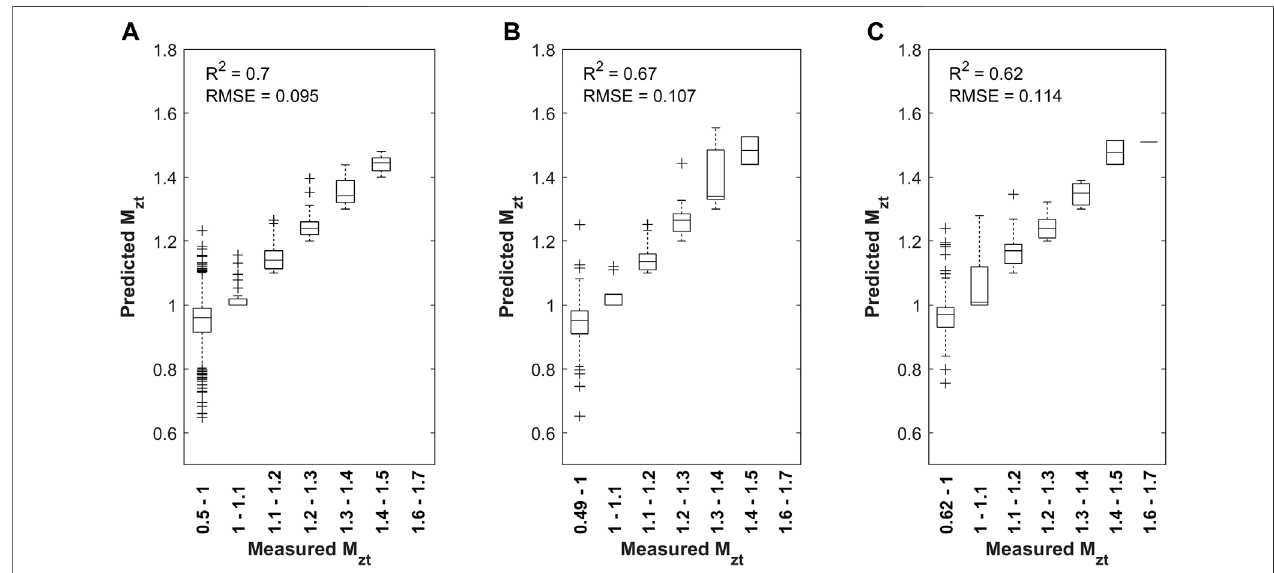
FIGURE11| Training,testing, andvalidationofasinglelayer,30neuronmodelforthesmooth-to-rough transitioncasesusing100 mhorizonalspacingDEMdata. (A) Training, (B) Testing, and (C) Validation.